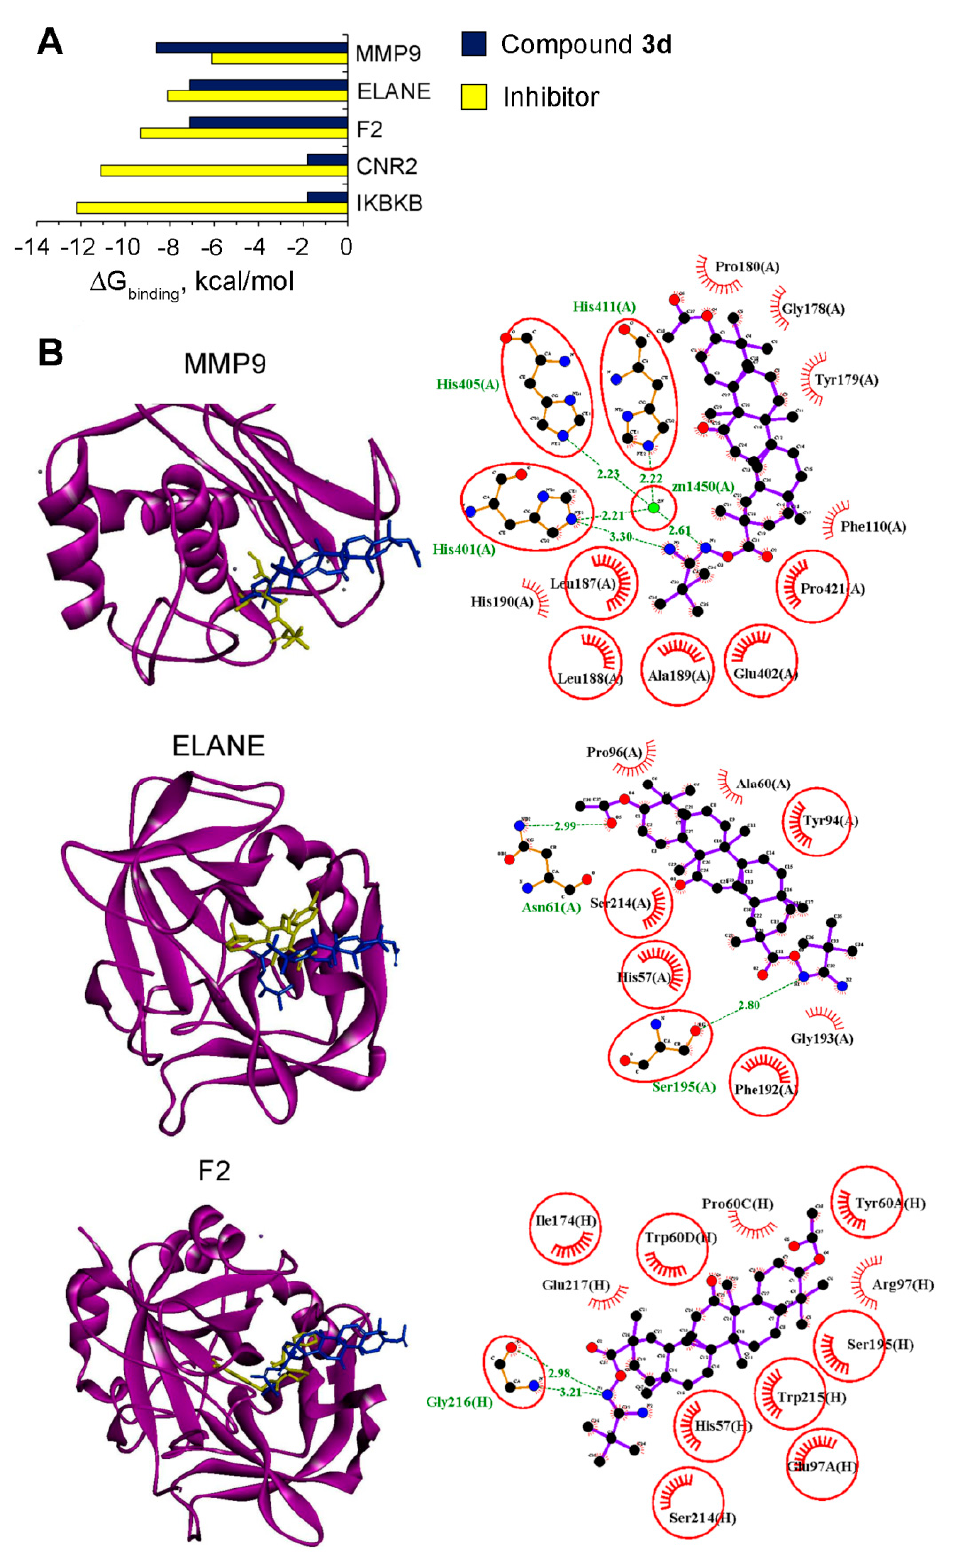
Figure 8. MMP9, neutrophil elastase (ELANE), and F2 are probable primary targets of compound 3d . ( A ) Binding energies of 3d and known inhibitors, with the top 5 probable targets of 3d being the most associated with rodent inflammatome. The binding energies were calculated by Autodock Vina. ( B ) The mode of binding of 3d to MMP9, neutrophil elastase (ELANE), and thrombin (F2). Stereo presentations of the docked pose of 3d in the mentioned proteins superimposed on corresponding